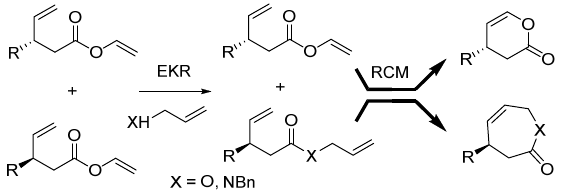
Scheme 1. The concept for the stereoselective DOS of chiral